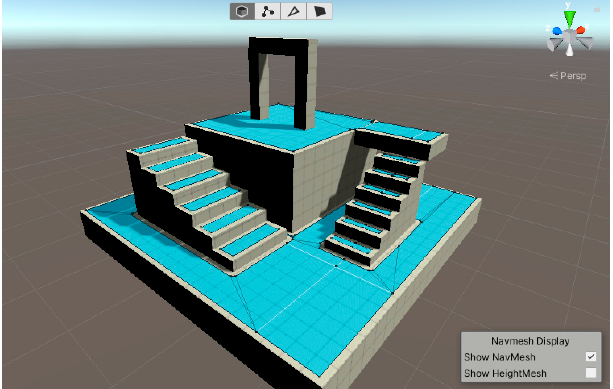
Figure 2. Example of the 3D model established by Probuilder.